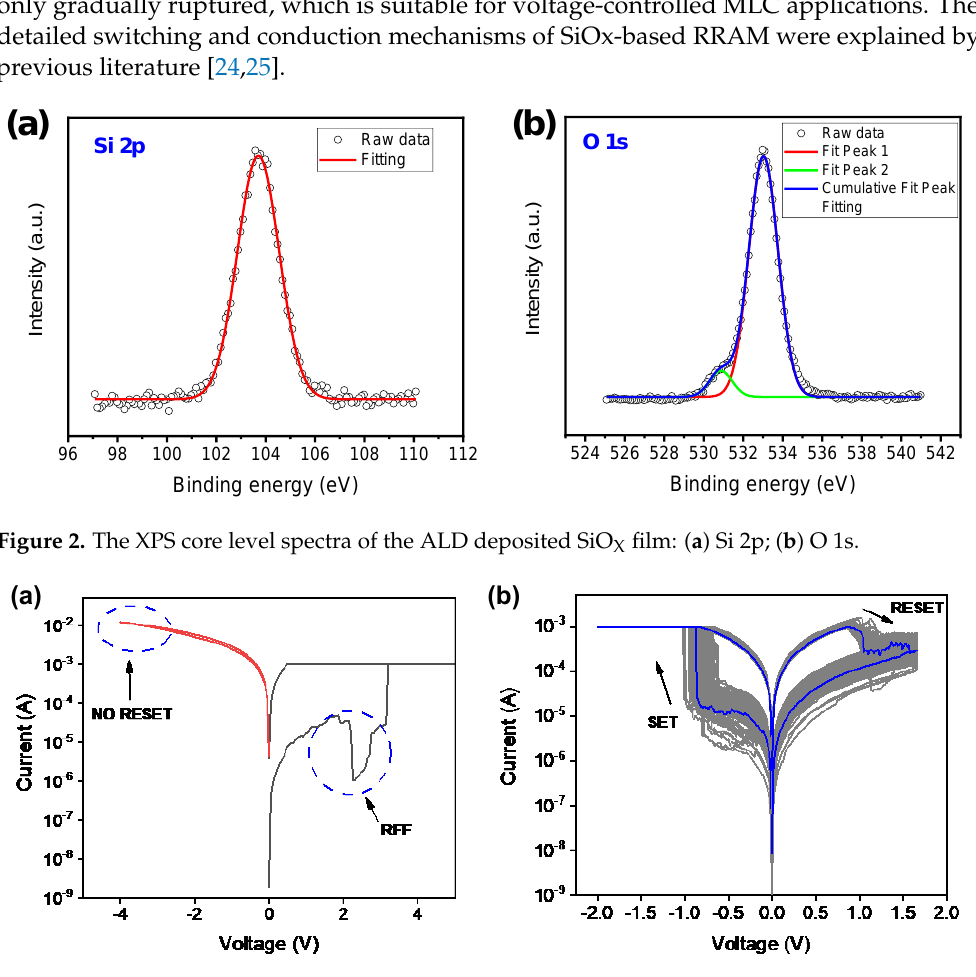
Figure 2. The XPS core level spectra of the ALD deposited SiO X film: ( a ) Si 2p; ( b ) O 1s.